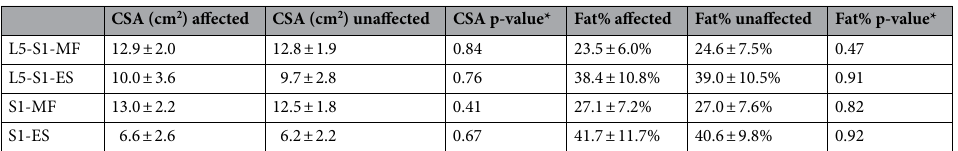
Table 1. Measurements (mean ± sd) of CSA and fatty infiltration (Fat%) of the multifidus (MF) and erector spinae (ES) on the affected and unaffected sides. *The p -values were obtained with Spearman partial correlation while controlling for the effects of sex and age.